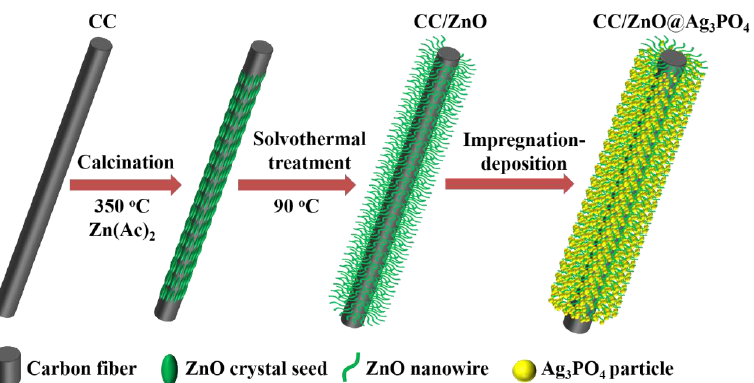
Figure 1. Schematic illustration for the synthesis procedure of the carbon cloth-supported ZnO and ZnO@Ag 3 PO 4 composite.